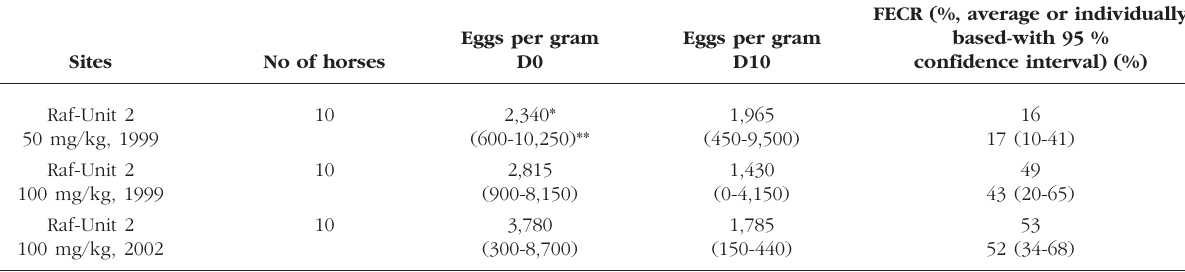
Table V. – Faecal egg count reduction test (FECR) after treatment with thiabendazole in horses from two sites (50 mg-100 mg/kg body weight)